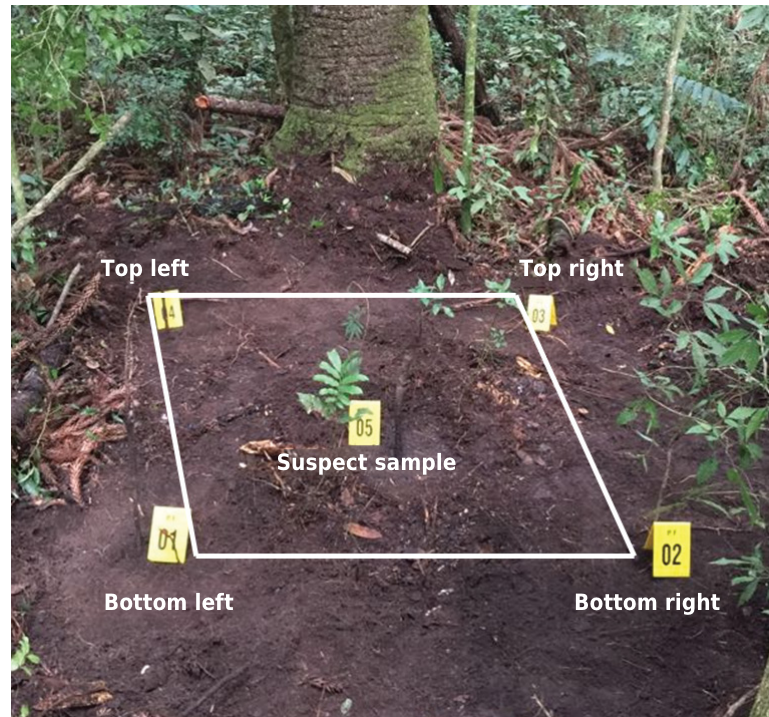
Figure 2. Design of the simulated crime scene for surface soil sampling. Source: modified from Testoni et al.